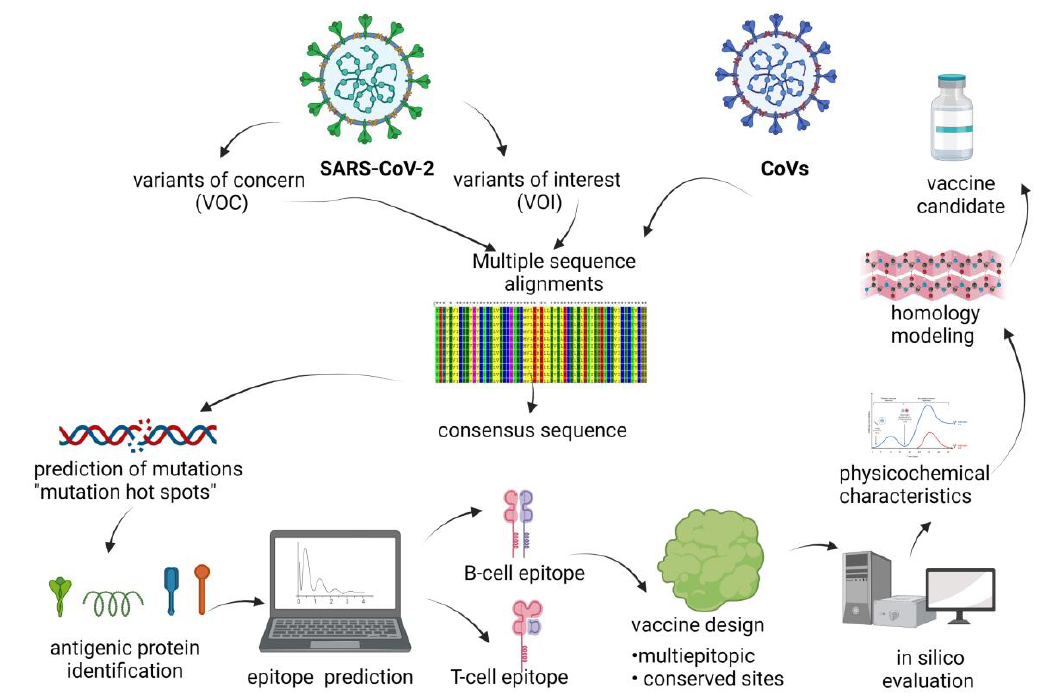
Figure 1. Design process of vaccine development against SARS-CoV-2. As a first step, of all the reported sequences, a consensus sequence would be obtained and analyses would be carried out to predict the probable mutation sites considering the 3D structural data using in silico studies. The data would enhance the prediction of epitopes leading to the design of an epitope vaccine. Created with BioRender.com (accessed on 29 October 2022).